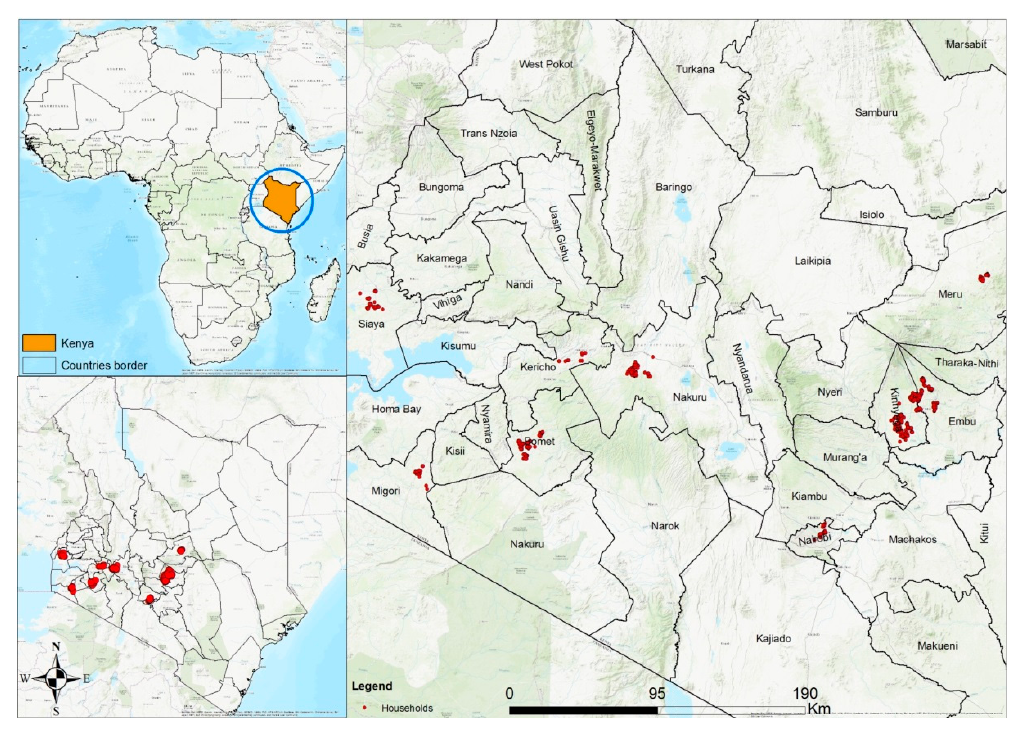
Figure 1. Map showing location of respondents across the nine counties included in the study.